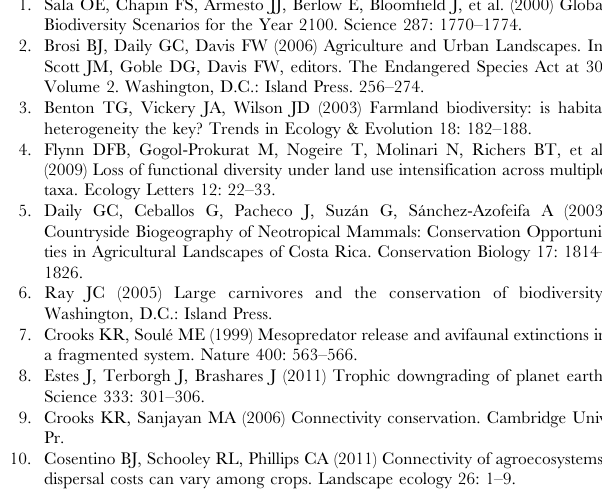
Model I.D. K Detection (p) , Intercept only Land cover 4 365 Land cover + season Occupancy ( y ) , Avocado orchard + grass/herbaceous Avocado orchard + woodland Avocado orchard Avocado orchard + distwild Intercept only Woodland Averaged model